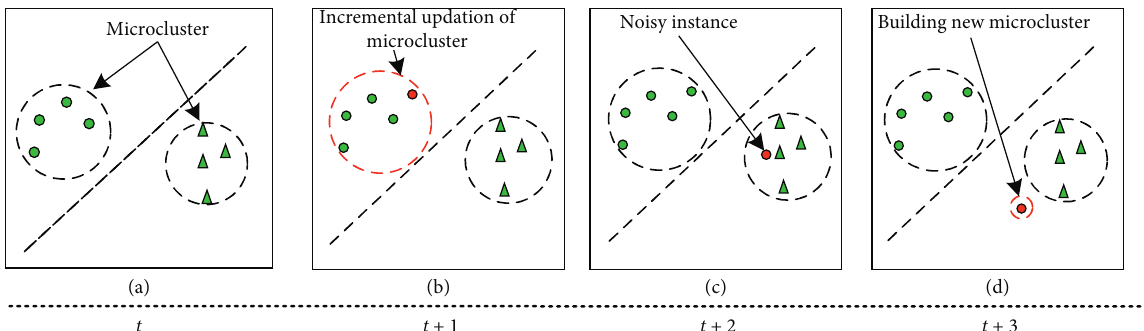
Figure 2: A demonstration of problem definition. In data stream, (a) microclusters (shape: dotted circle) are developed by historical instances (color: green) with positive class (shape: circle) and negative class (shape: triangle); (b) when new instance (color: red, shape: circle) comes, microcluster is updated (color: red, shape: dotted circled), and (c) the old microcluster involves noisy instance (color: red, shape: circle), and (d) concept drift (color: red, shape: circle) is detected and a new microcluster (color: red, shape: dotted circle) is